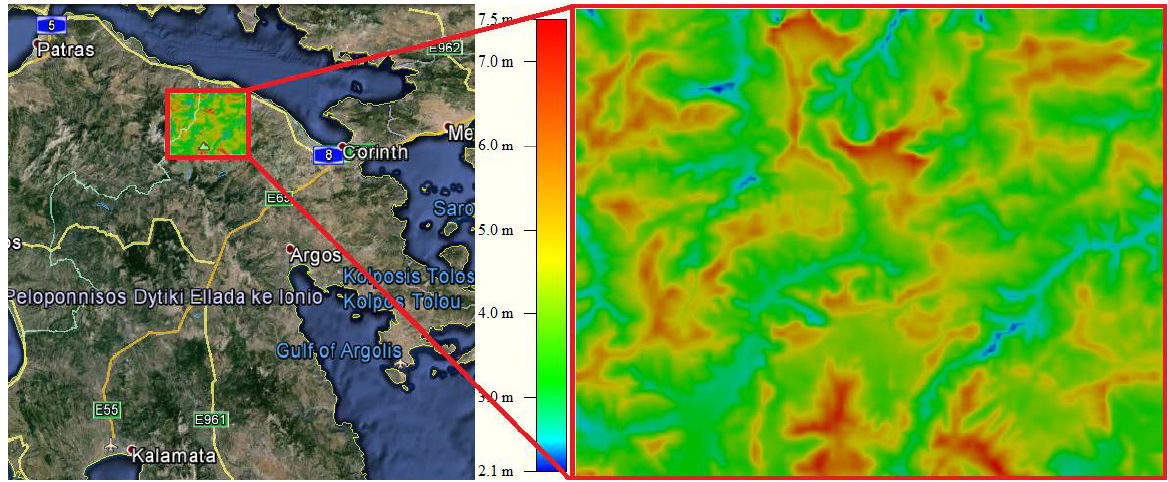
Figure 2. Wind Resource Analysis in a significant part of Corinthia region,